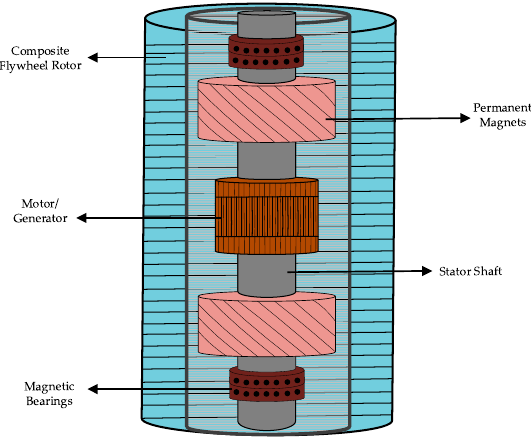
Figure 2. Structure of Integrated hollow FESS.